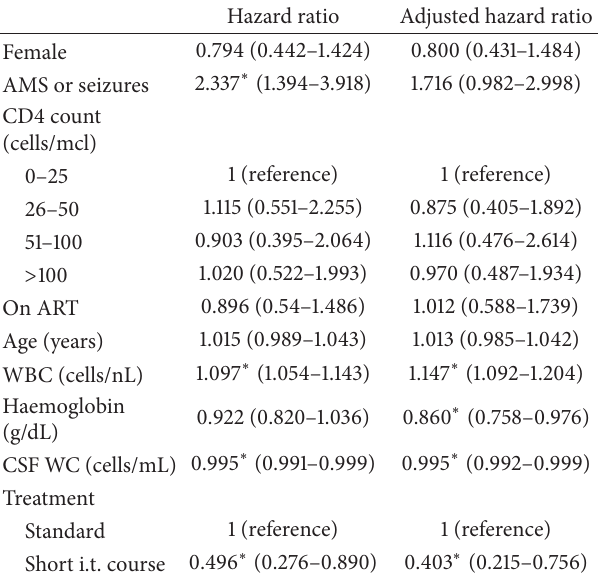
Table 2: Univariate and multivariate analysis of factors associated with mortality using Cox proportional hazard methods.